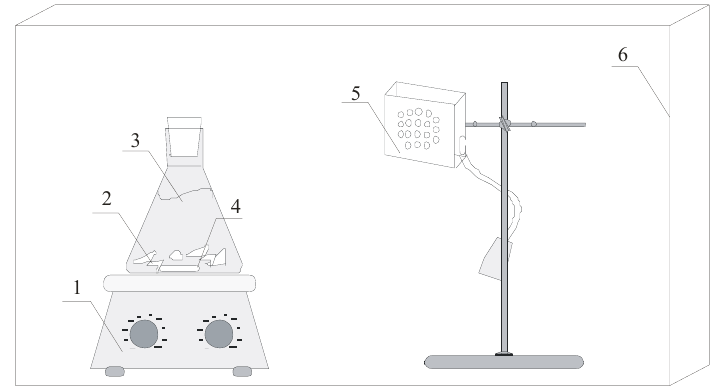
FIGURE 6. Scheme of the experimental apparatus: 1, stirrer; 2, fragments of glass conjugates; 3, reactor; 4, magnetic stirrer; 5, bank of light-emitting diodes; 6, dark box.